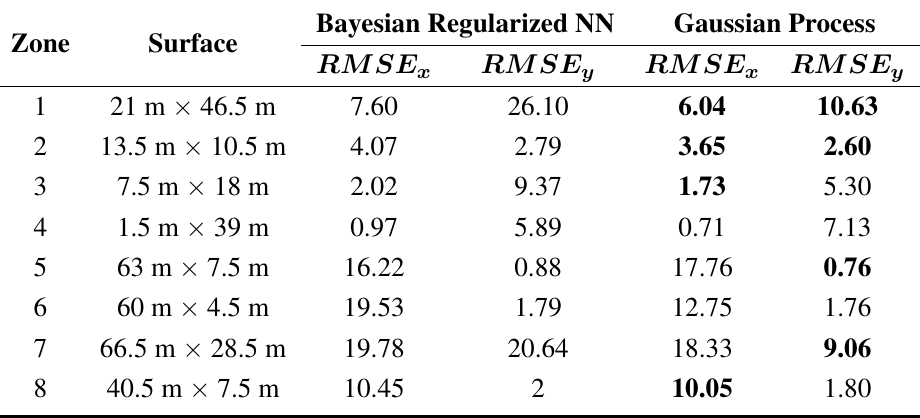
Table 5. RMSE (meters) performing feature selection based on automatically-clustered data in Building